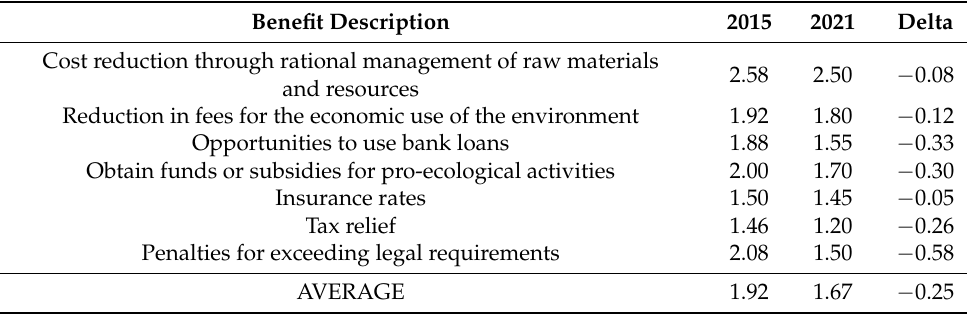
Table 5. Economic and financial benefits of the EMAS.